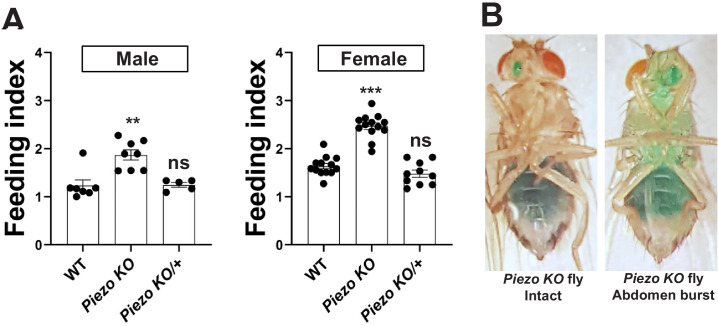
Feeding characteristics of Piezo knockout flies.(A) Feeding indices of male and female wild-type (WT) and Piezo knockout homozygote (Piezo KO) and heterozygote (Piezo KO/+) flies. Flies were fasted, given brief access (30 min) to dye-colored food, and scored. n (left to right) for male: 7, 8, and 5 and female: 13, 13, and 10 trials involving 12 flies per trial, mean ± SEM, **p<0.0005, ***p<0.0001, ns: not significant by ANOVA Dunnett’s multiple comparison test. (B) Piezo KO flies were fasted and then fed with green dye-labeled food; images are depicted of flies with either intact abdomens (left) or bursted abdomens (right).
Figure 4—figure supplement 2—source data 1.Numerical data to support the graph in Figure 4—figure supplement 2.